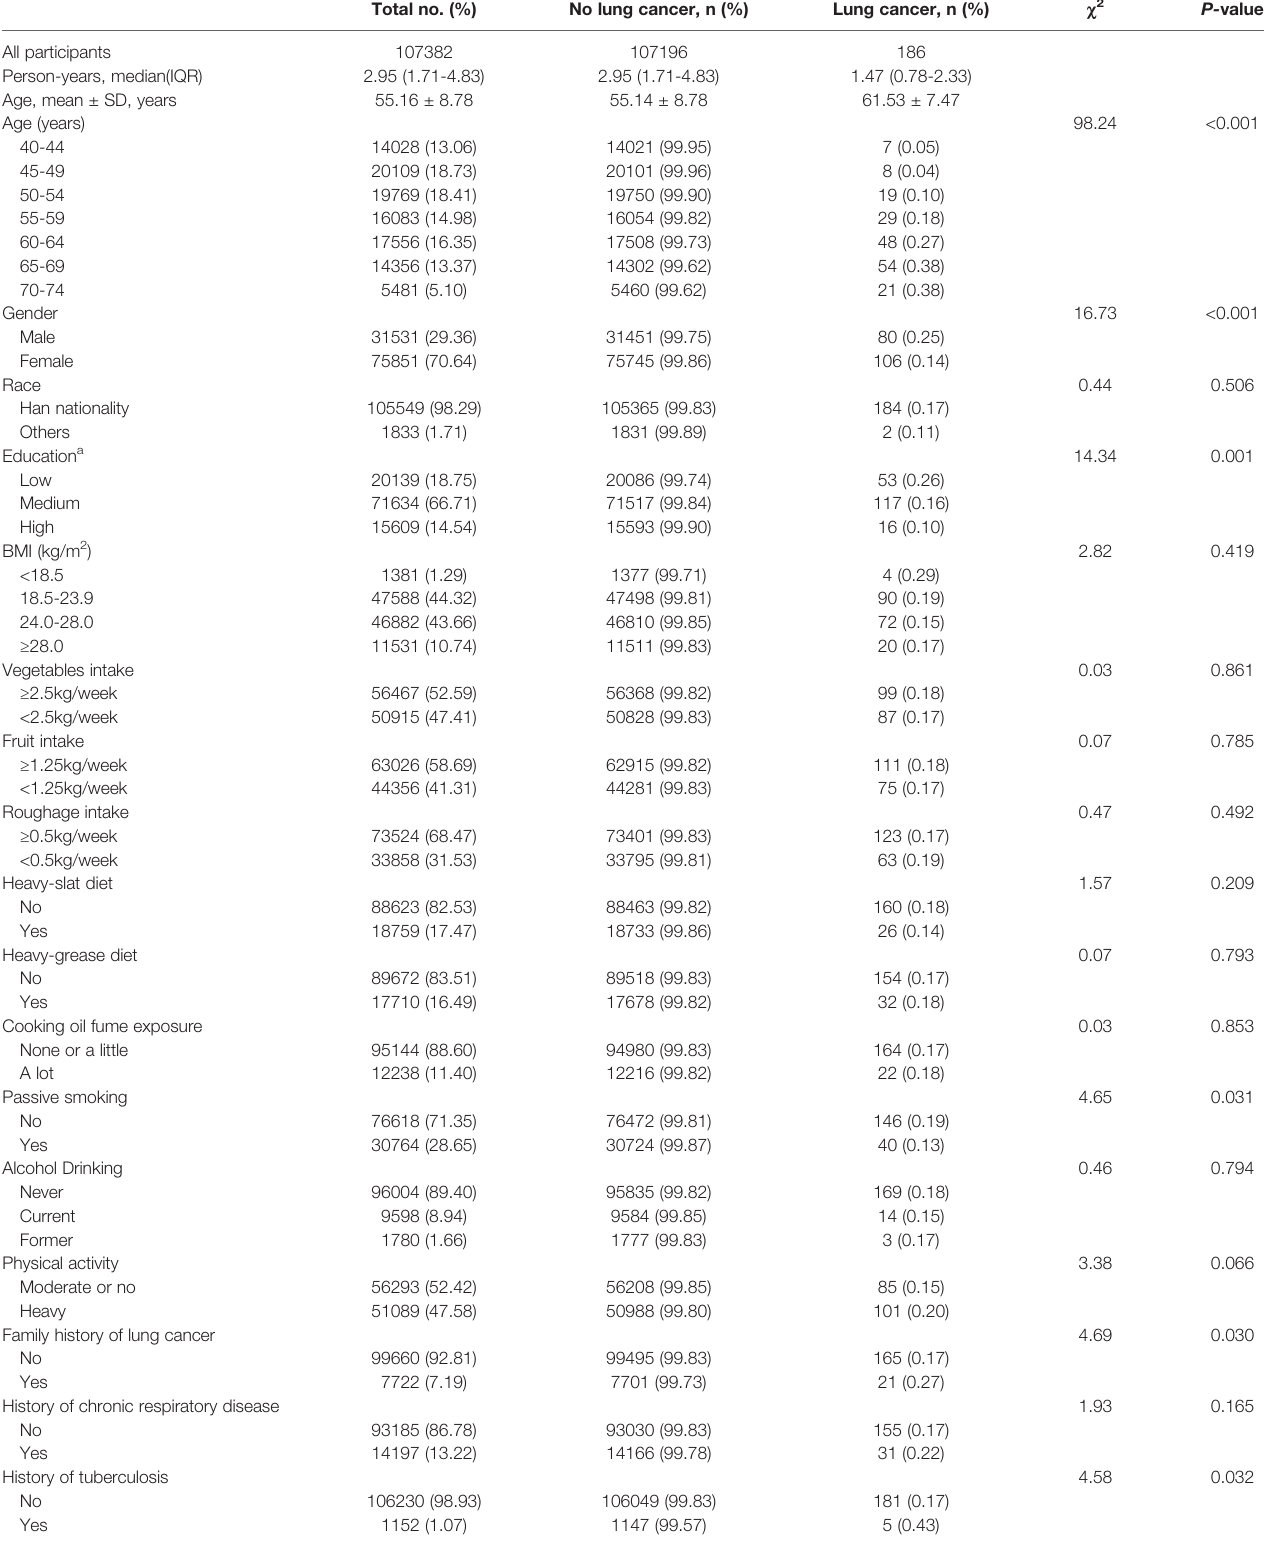
TABLE 1 | Baseline characteristics of the study population in the training